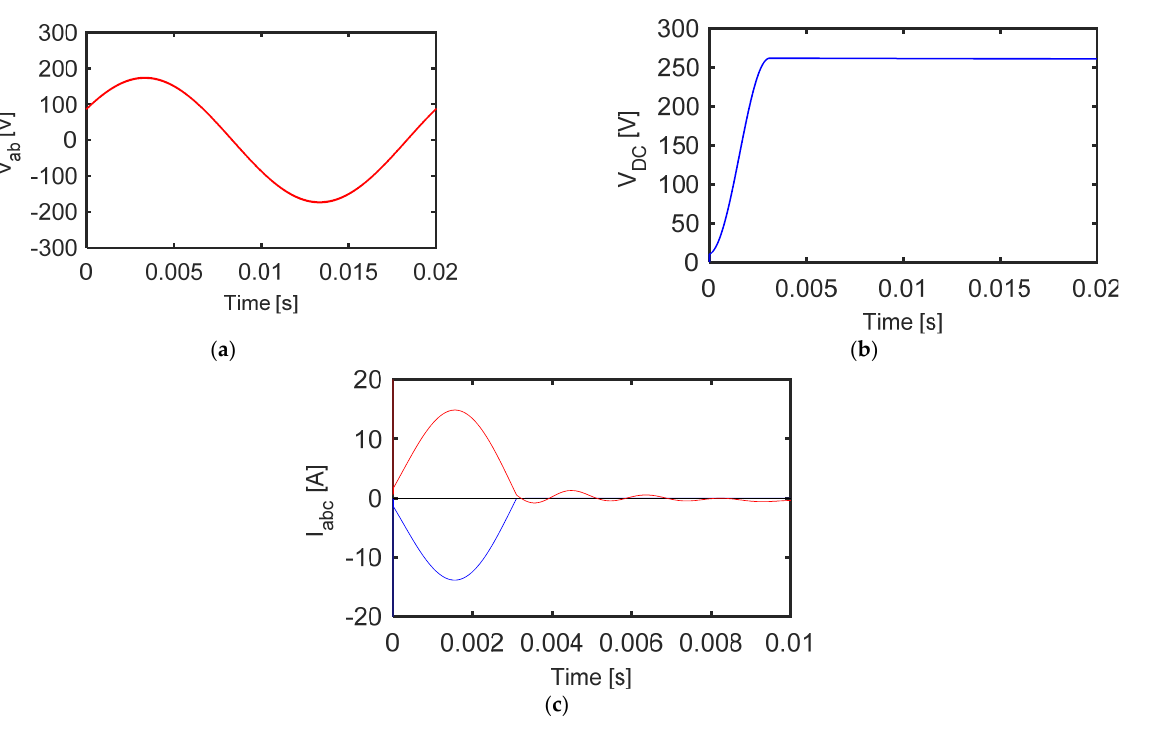
Figure 7. Simulation testing of the clamping circuit at start-up without operating the PWM of the rectifier and charging using line voltage V ab ( a ) Line-input voltage V ab , ( b ) DC-link voltage and ( c ) input current for MC.